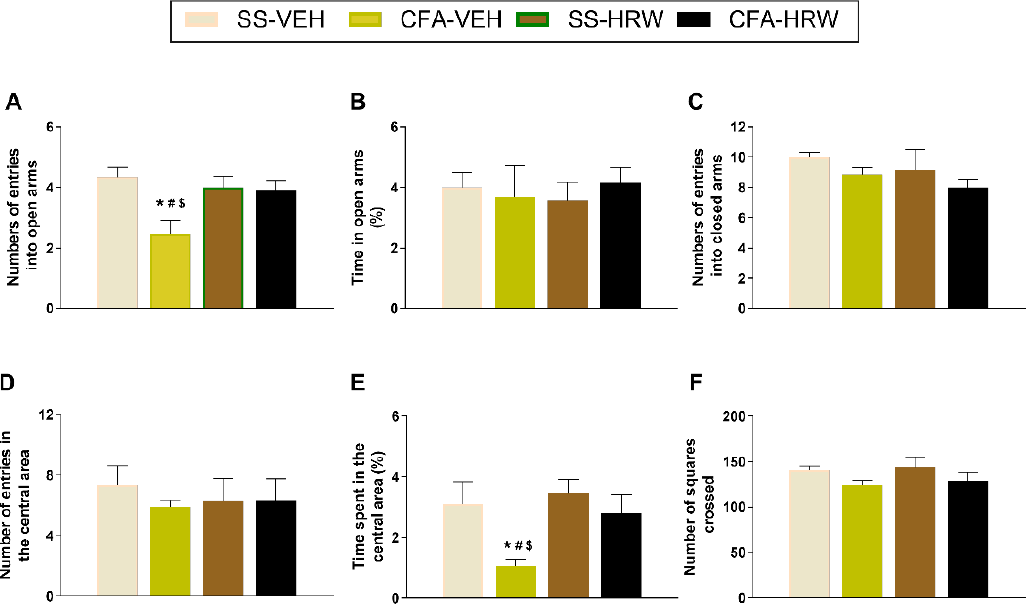
Figure 4. Treatment with HRW inhibited the anxiety-like behaviors linked with chronic inflammatory pain. The effects of the intraperitoneal treatment with HRW or VEH in the EPM and OF tests, at 16 days after CFA injection, are represented. In the EPM test, the number of entries to the open arms ( A ), the percentage of time spent in the open arms ( B ), and the number of entries into the closed arms ( C ) are shown. In the OF test, the number of entries in the central area ( D ), the percentage of time spent in the central area ( E ), and the number of squares crossed ( F ) are represented. The effects of HRW and VEH in SS-injected mice are also shown. For each test evaluated, * denotes significant differences vs. SS-injected mice treated with VEH, # vs. SS-injected mice treated with HRW, and $ vs. CFA-injected mice treated with HRW ( p < 0.05; one-way ANOVA and Student–Newman–Keuls test). Data are presented as mean values ± SEM; n = 8 animals for group.